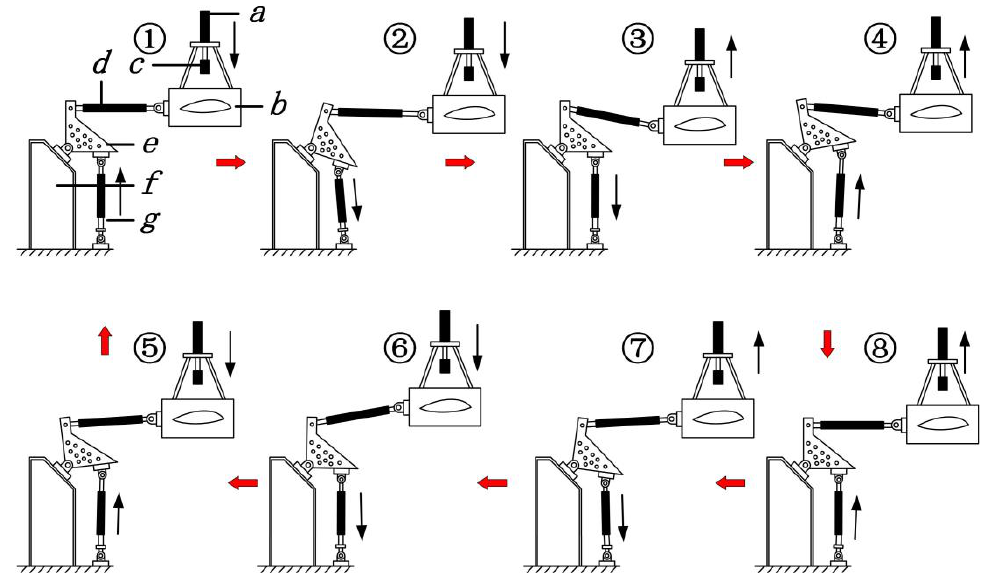
Figure 8. Movement process of blades in a single cycle when using hybrid biaxial fatigue testing device. a is hydraulic loader of flapwise, b is cross section of blade and fixture, c is hydraulic rod and vibration mass, d is push rod, d is push rod, e is rocker arm, f is foundation, g is hydraulic loader of edgewise.